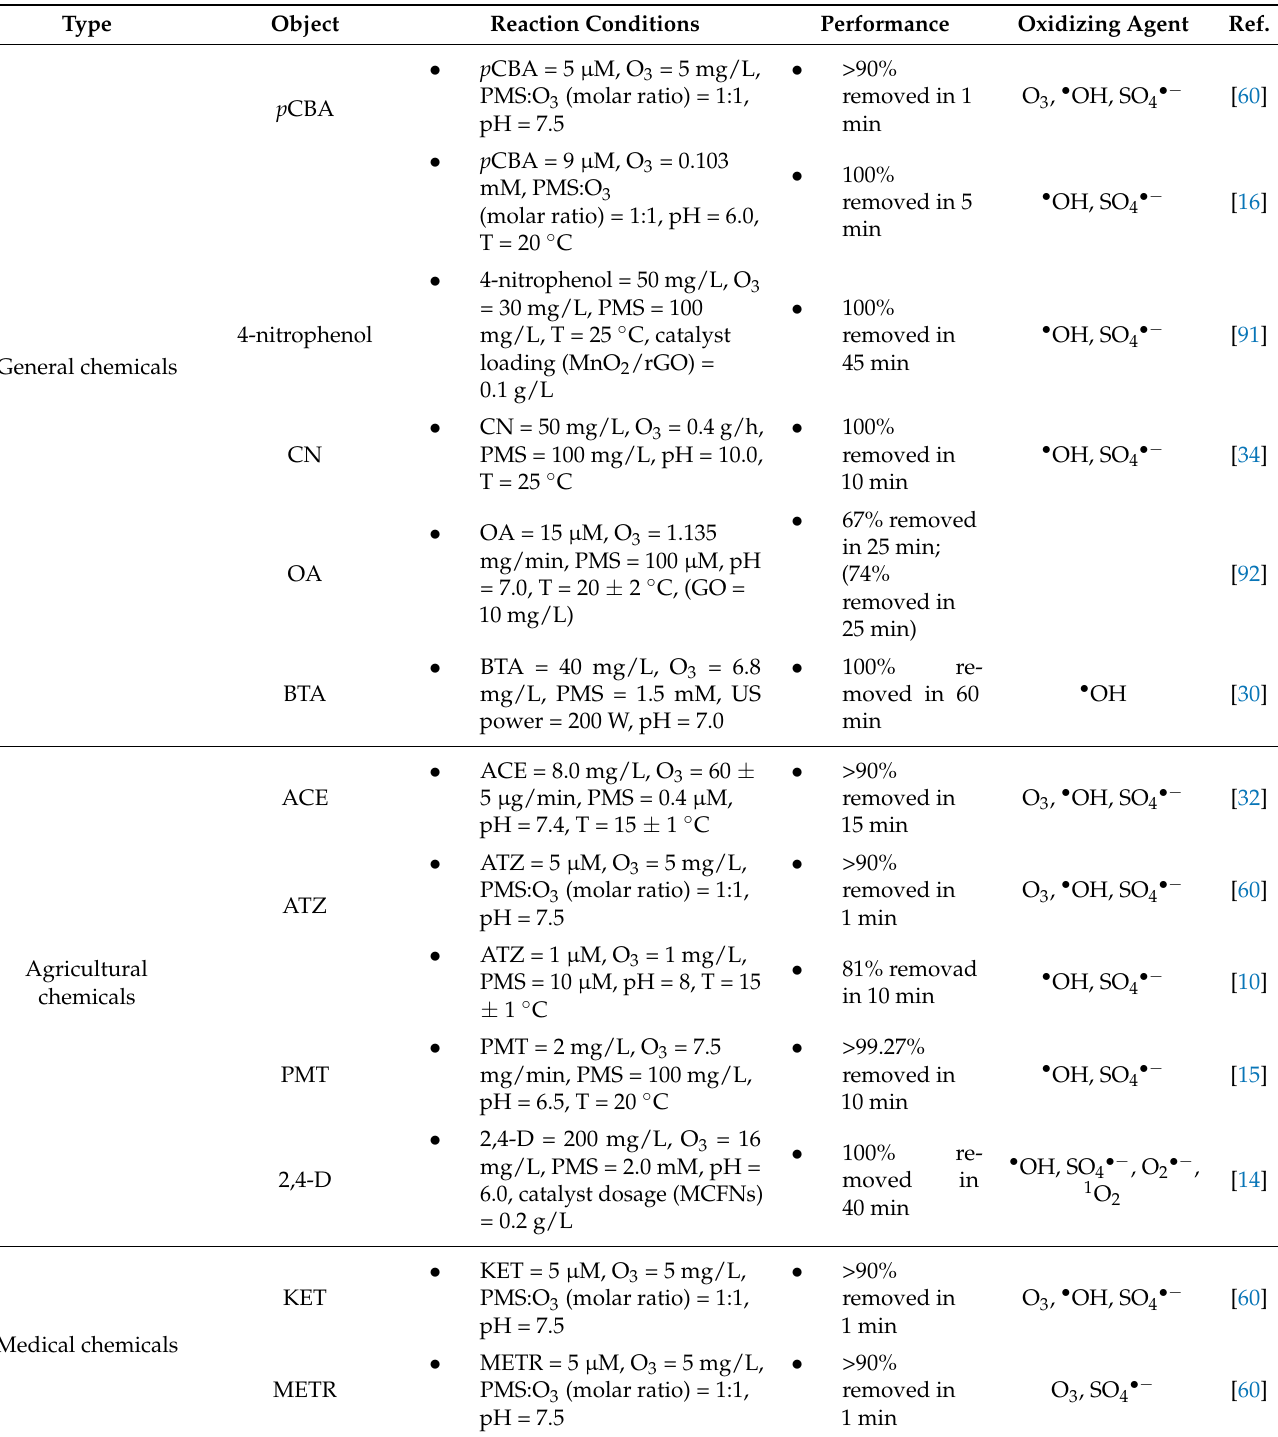
Table 2. Degradation effect of O 3 /PMS process on